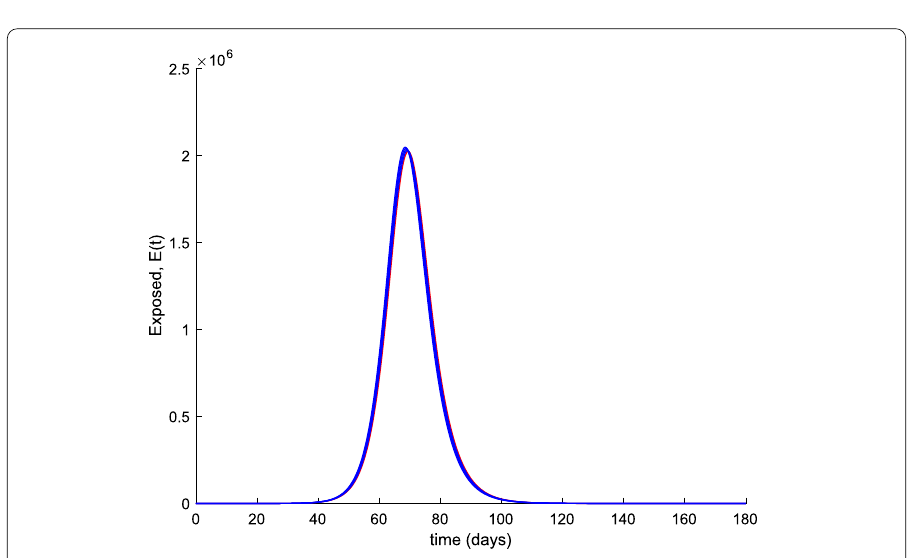
Figure 4 Variation of the number of exposed individuals with β hr in the absence of control